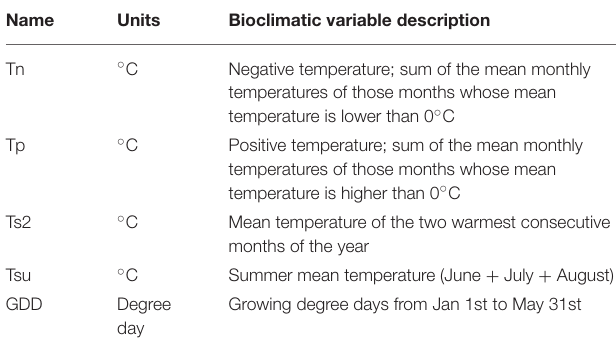
TABLE 1 | Bioclimatic variables derived from climate